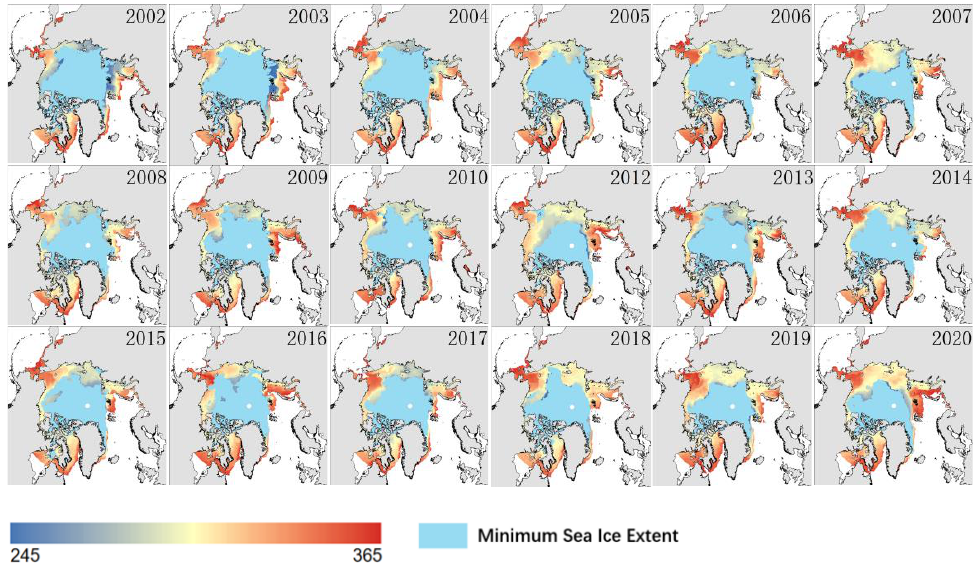
Figure 10. Spatial distribution of Arctic sea ice freeze-up dates (DoY) from 2002 to 2020 . Table 7. The D oY of Arctic sea ice complete freeze from 2002 to 2020.